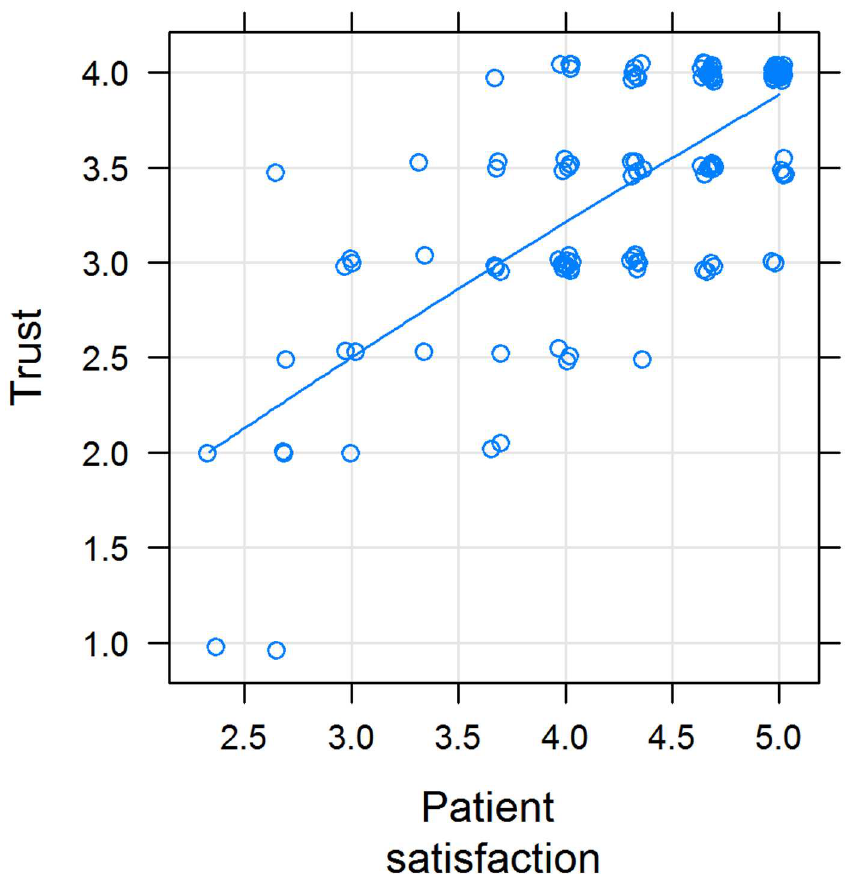
Fig 7. Association between trust in the physician (Trust) and patient satisfaction; X-Y scatterplot. Variableswere positivelycorrelated(rho = 0.66; P value < 2.2e- 16 ). The line represents a cubic smoothing